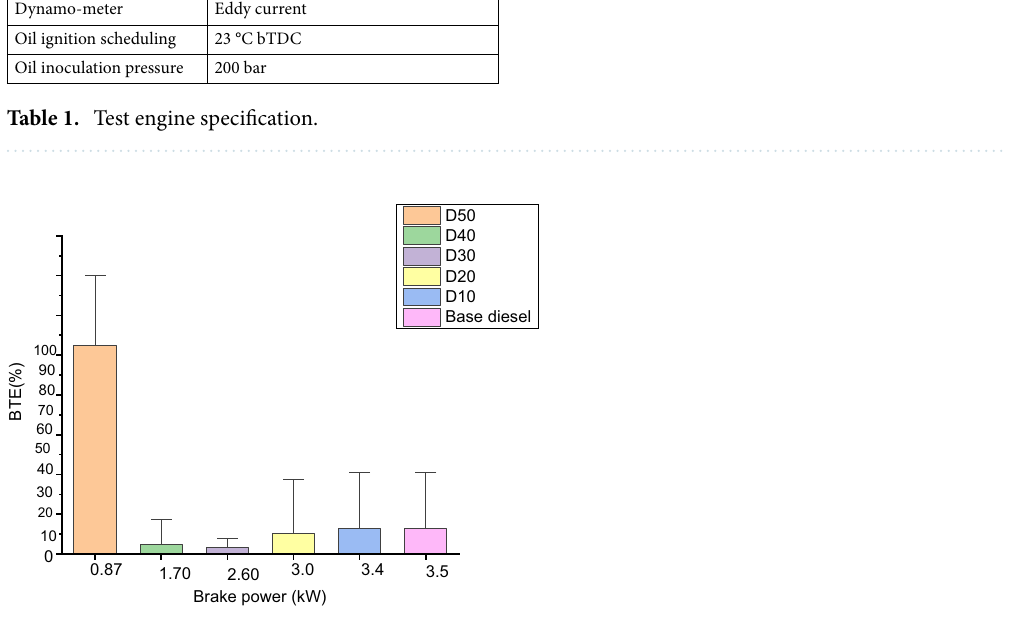
Figure 4. BTE vs. brake